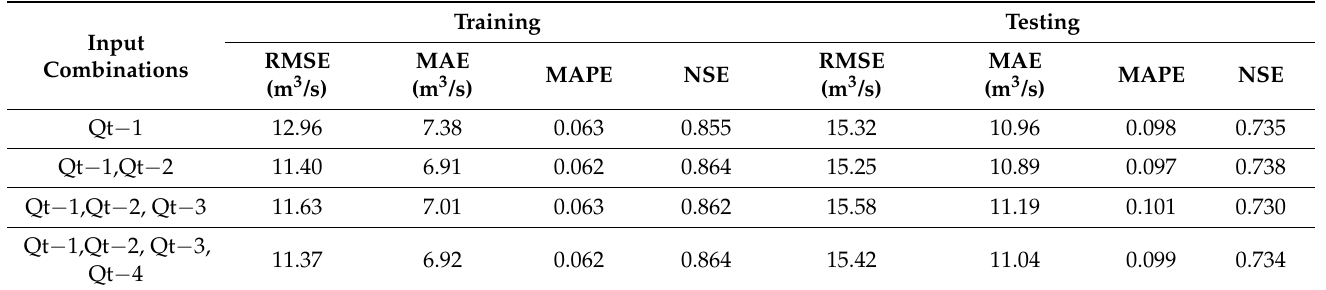
Table 4. Training and testing statistics of the MARS models using different input combinations for daily streamflow prediction—Skallbole Station (downstream).